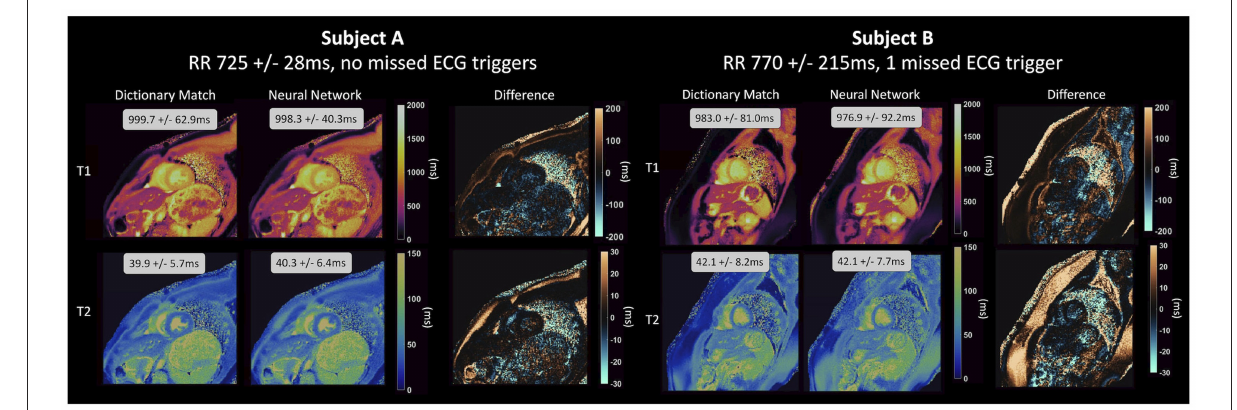
FIGURE4 Parameter maps generated by a NN for cardiac MRF from Hamilton et al. (82) for two healthy subjects and compared to maps generated using dictionary matching. The feedforward network with skip connections that was used takes the real and imaginary components of the fingerprint and the RR intervals as input and outputs parameter estimates for T 1 and T 2 on a fingerprint-wise basis. The network produces accurate parameter estimations for different cardiac rhythms, even for subject B, with a variable heart rate and 1 missed ECG-trigger.